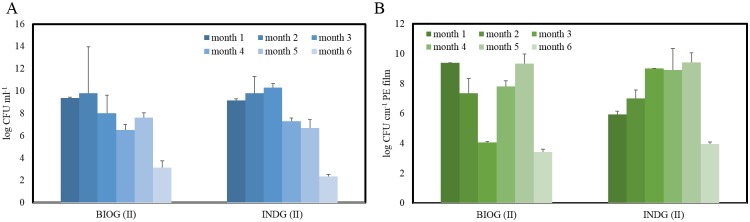
Cell densities.A) Abundances of free cells in the different treatments during phase II and B) abundances of the attached cells on the PE pieces during phase II.